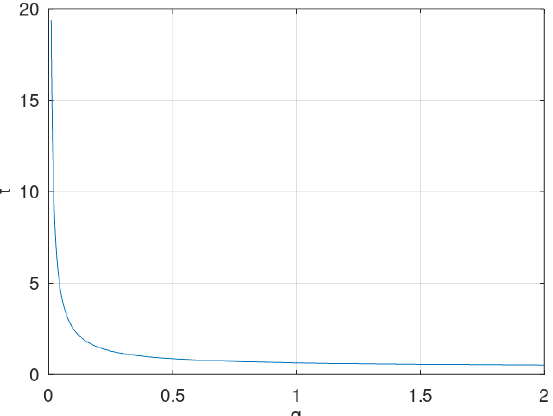
Figure 1. Rényi entropy (41) as a function of t ( ≥ 0.1 ) , for several values of α = 1 and θ = 0.